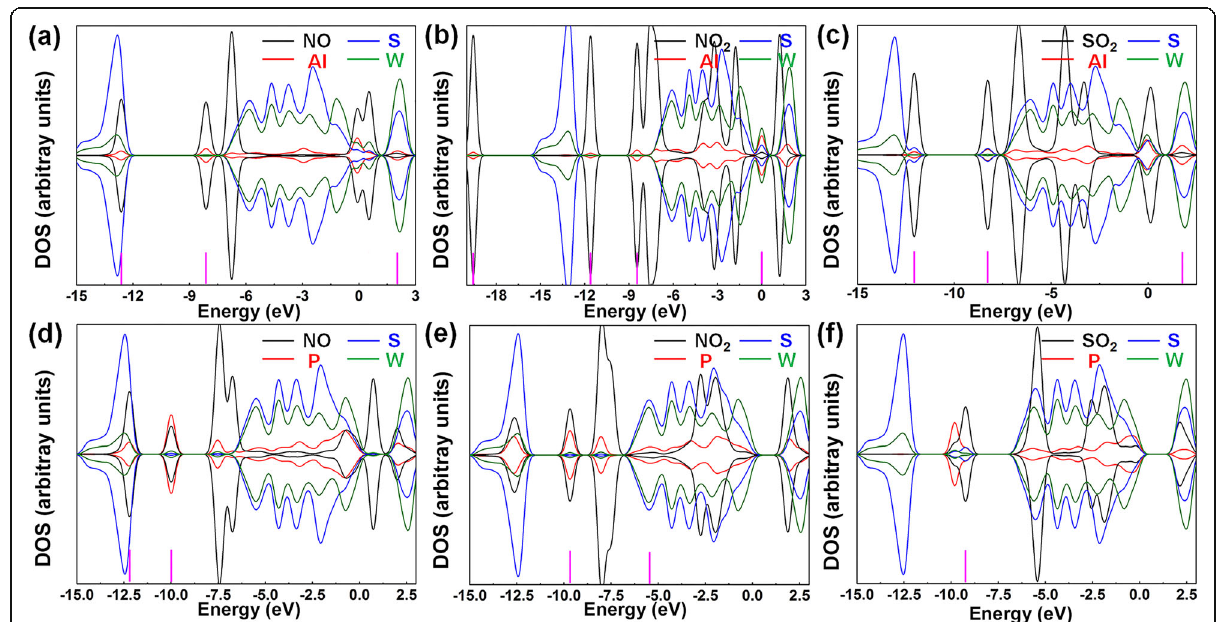
Fig. 5 DOS of a NO, Al, S, and W atoms; b NO 2 , Al, S, and W atoms; c SO 2 , Al, S, and W atoms; d NO, P, S, and W atoms; e NO 2 , P, S, and W atoms; and f